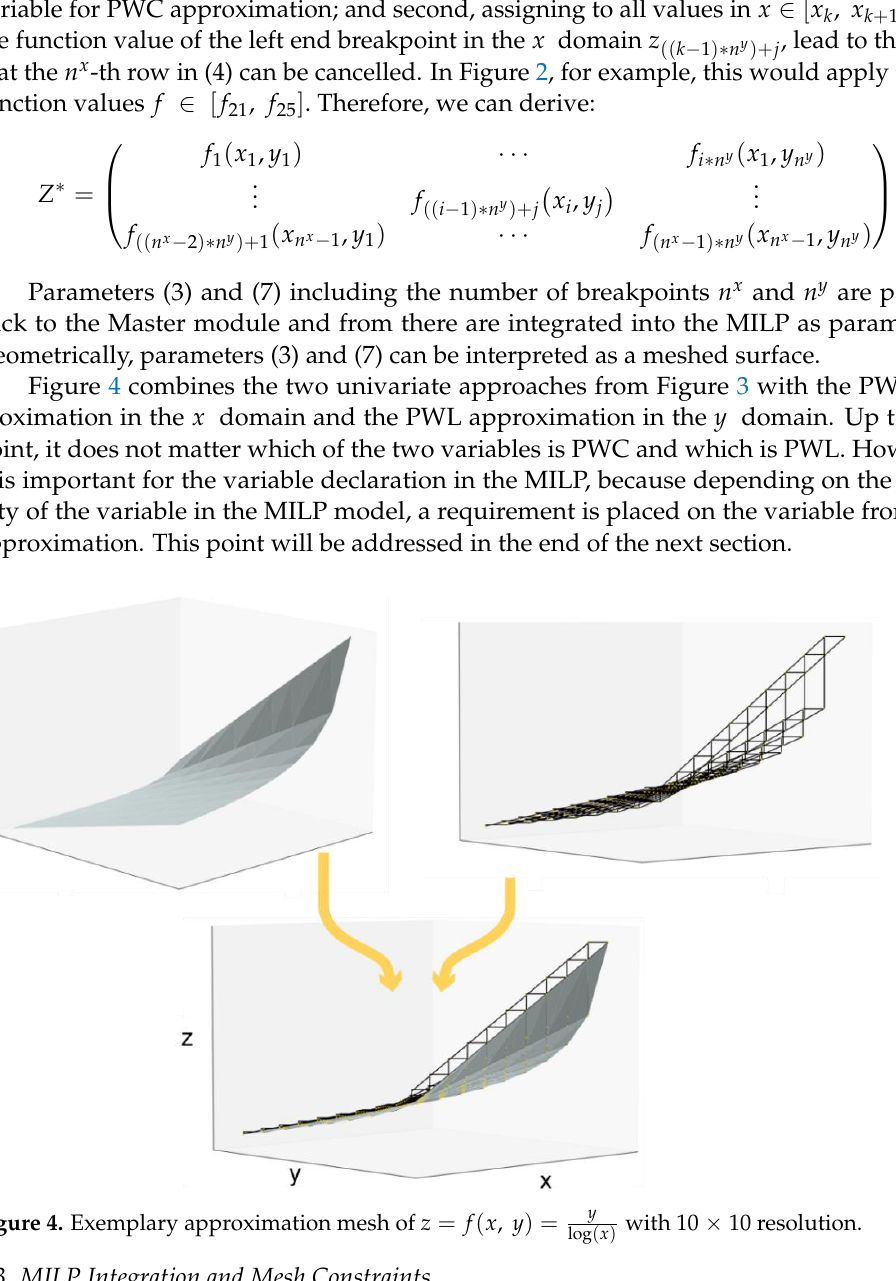
with 10 × 10 log ( x ) with 10 × 10 resolution. log(𝑥)